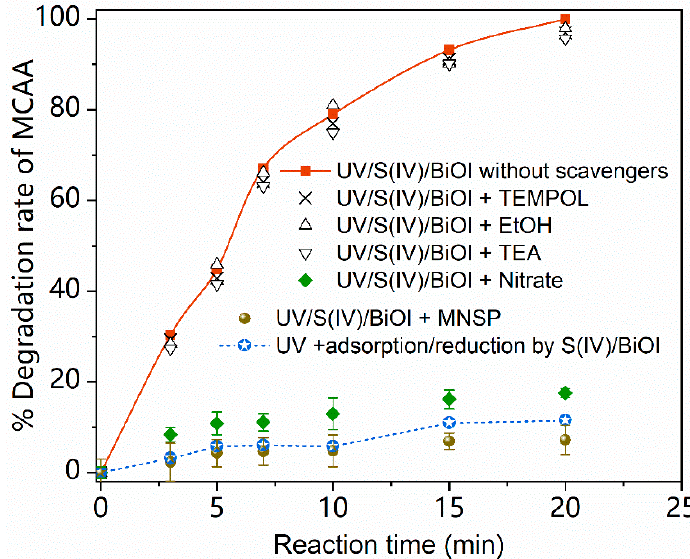
Figure 4. MCAA degradation by ultraviolet-activated S(IV) process combined with BiOI (UV/S(IV)/BiOI) in the presence of different scavengers. Conditions: [BiOI] 0 = 1.0 g ⋅ L − 1 (84.9 μ M as I); [S(IV)] 0 = 1.0 mM; the initial concentration of 4-hydroxytetramethyl-piperidine-1-oxyl (TEMPOL), ethanol (EtOH), triethanolamine (TEA), 2-methy-2-nitrosopropane (MNSP) and nitrate is 0.4 mM; [DO] 0 = 0.22 mM (7.1 mg ⋅ L − 1 ); pH = 7.0, 25 ± 1 °C.